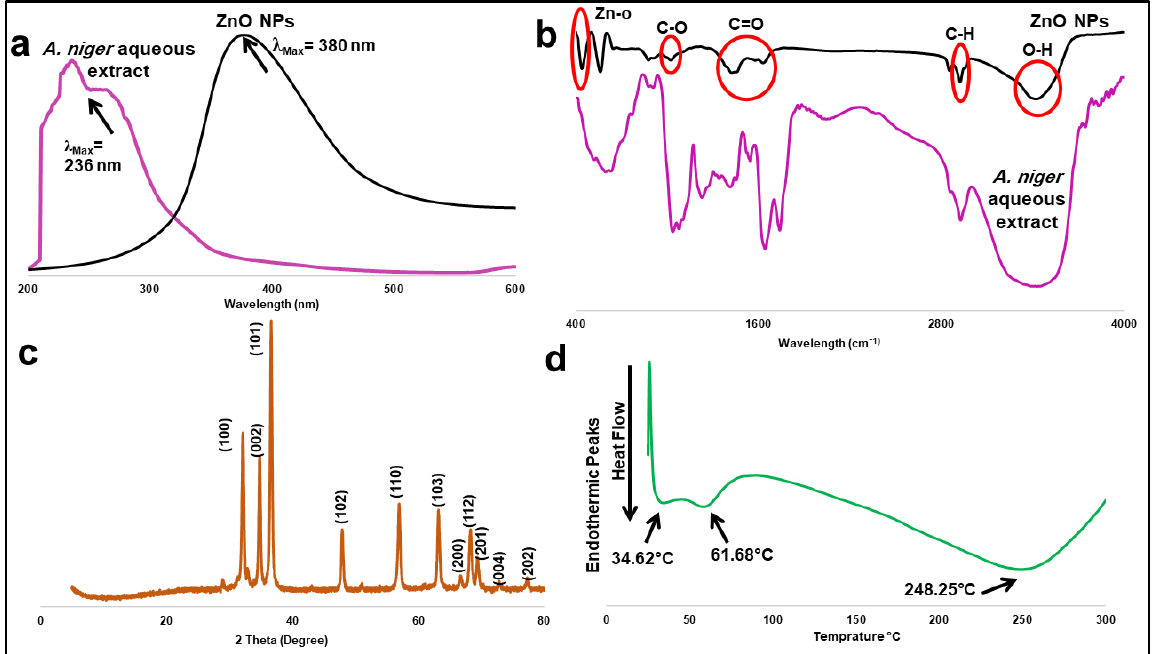
Figure 2. Different analytical spectra of ZnO NPs synthesized from A. niger . ( a ): UV spectrum, ( b ): FTIR bands, ( c ): XRD pattern, and ( d ): DSC curve. ( b ): FTIR bands, ( c ): XRD pattern, and ( d ): DSC